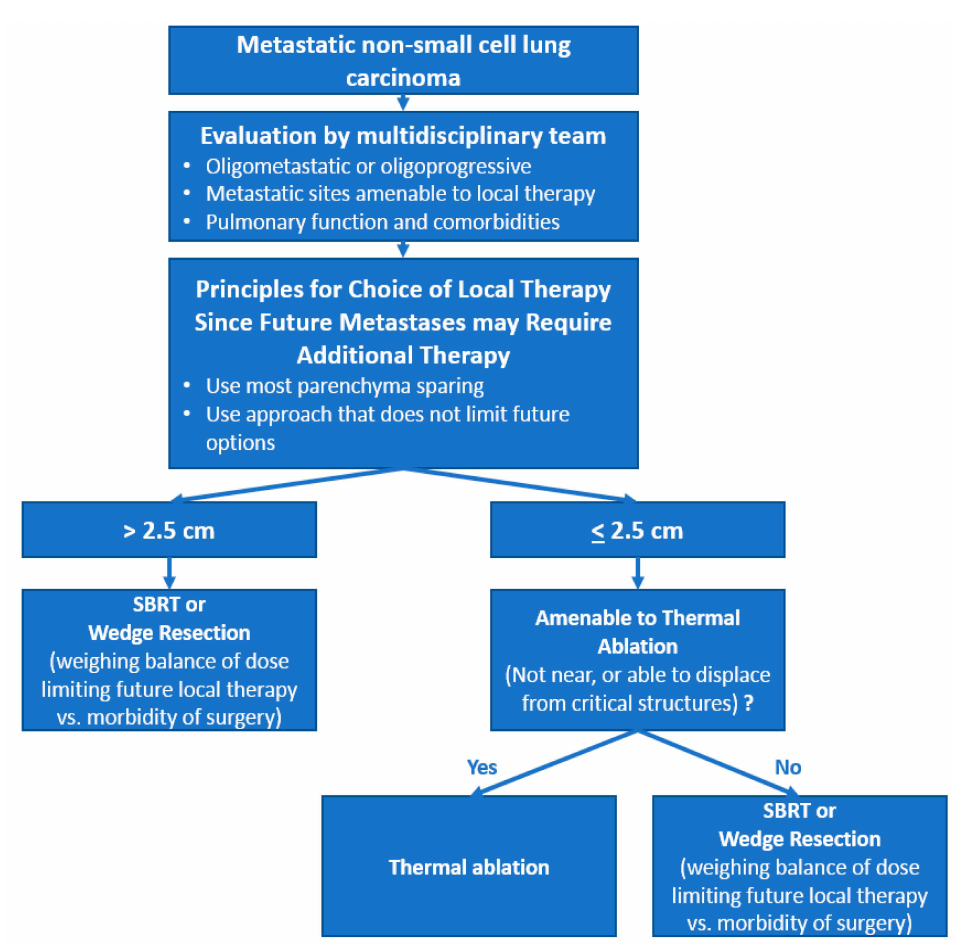
Figure 2. Proposed decision algorithm for local ablation therapy of oligometastatic non-small cell lung